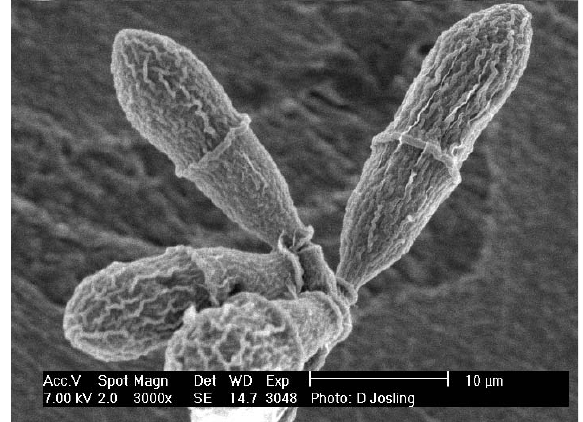
FIG. 1 SEM of conidia from a South African isolate of Dudding- tonia flagrans